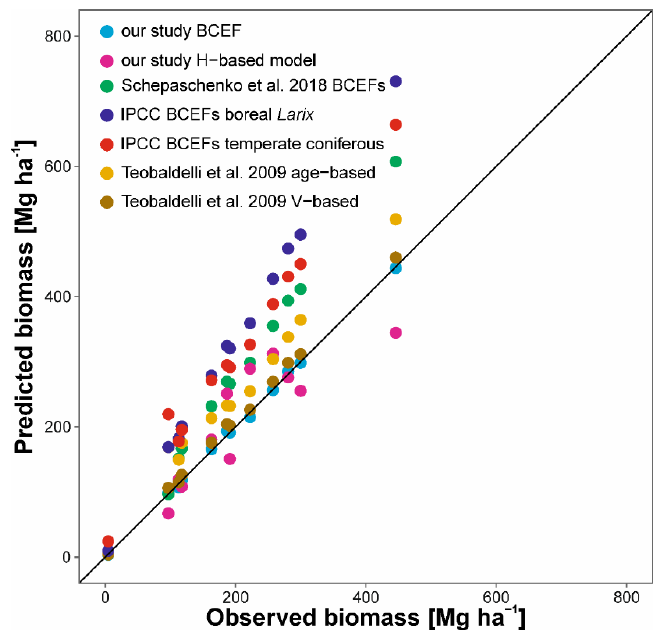
Figure 6. Aboveground biomasses calculated by our models, published models of BCEFs [24], BCEFs recommended by Intergovernmental Panel on Climate Change (IPCC) guidelines [16] and Schepaschenko et al. [41], compared with observed biomasses (calculated using plot-specific equations). Line indicates 1:1 proportion.